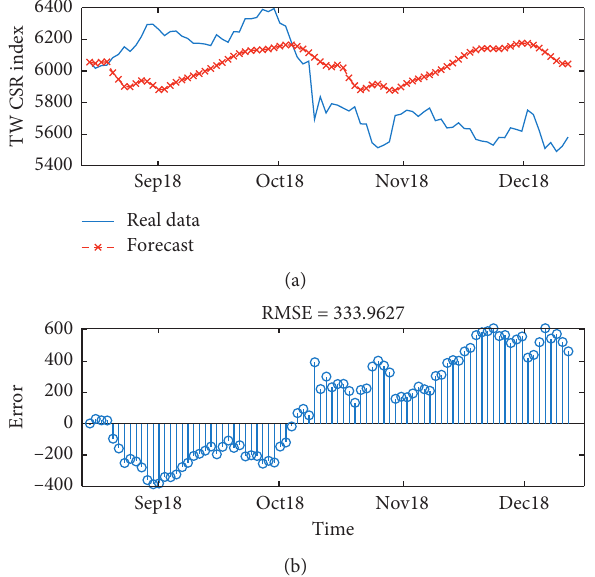
Figure 4: RMSE results from the LSTM model for Taiwan CSR index forecast and actual verification data. The RMSE is 333.9627.